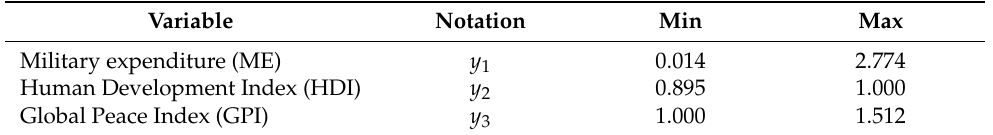
Table 7. Limits of the ε -efficient frontier.